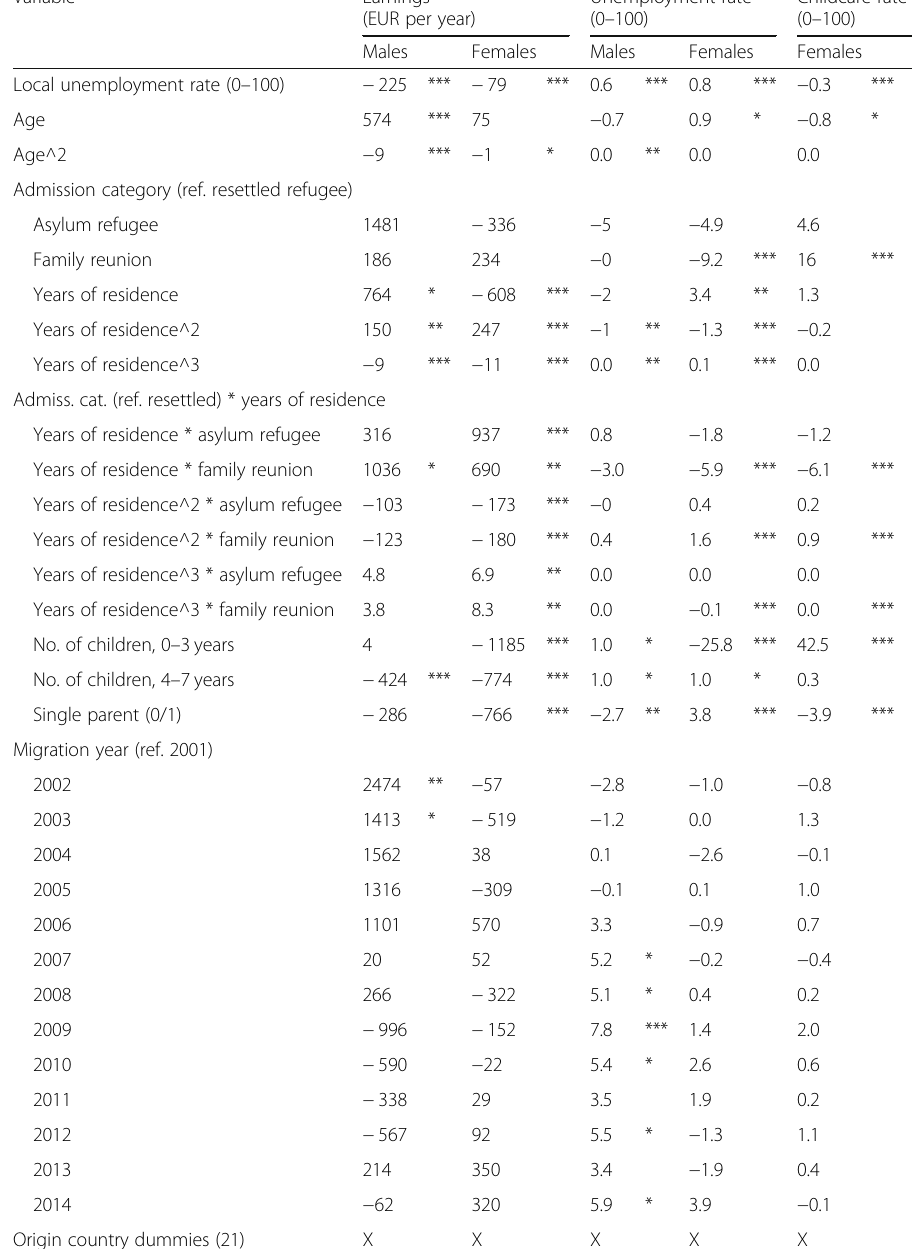
Table 3 Regression coefficients of the control